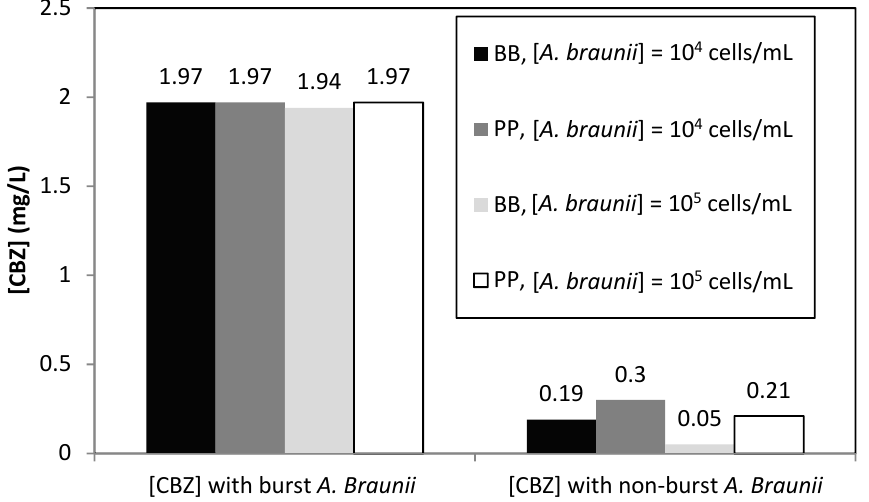
Figure 6. CBZ concentration in BB and PP media with burst and non-burst cells for an initial CBZ concentration of 2.5 mg/L and an inoculum concentration of A. braunii between 10 4 and 10 5 cells/mL.